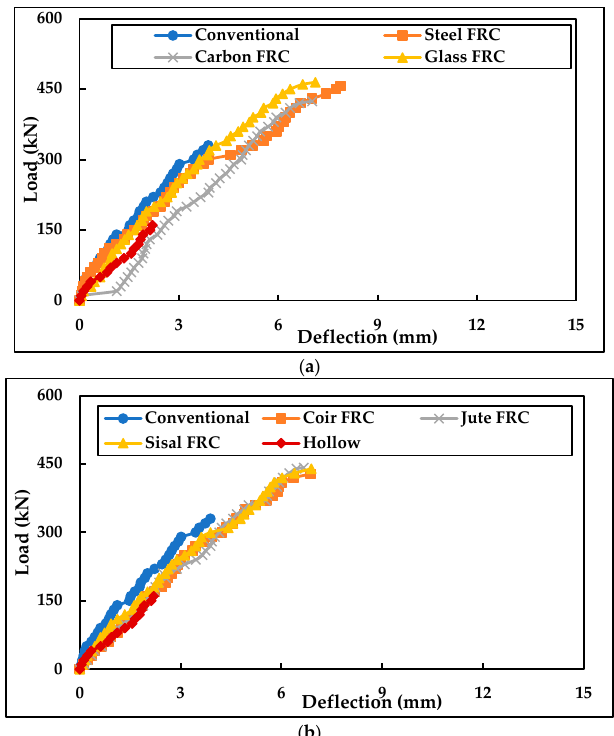
Figure 14. Graphical illustration of load vs. deflection. ( a ) Artificial FRC, ( b ) Natural FRC.